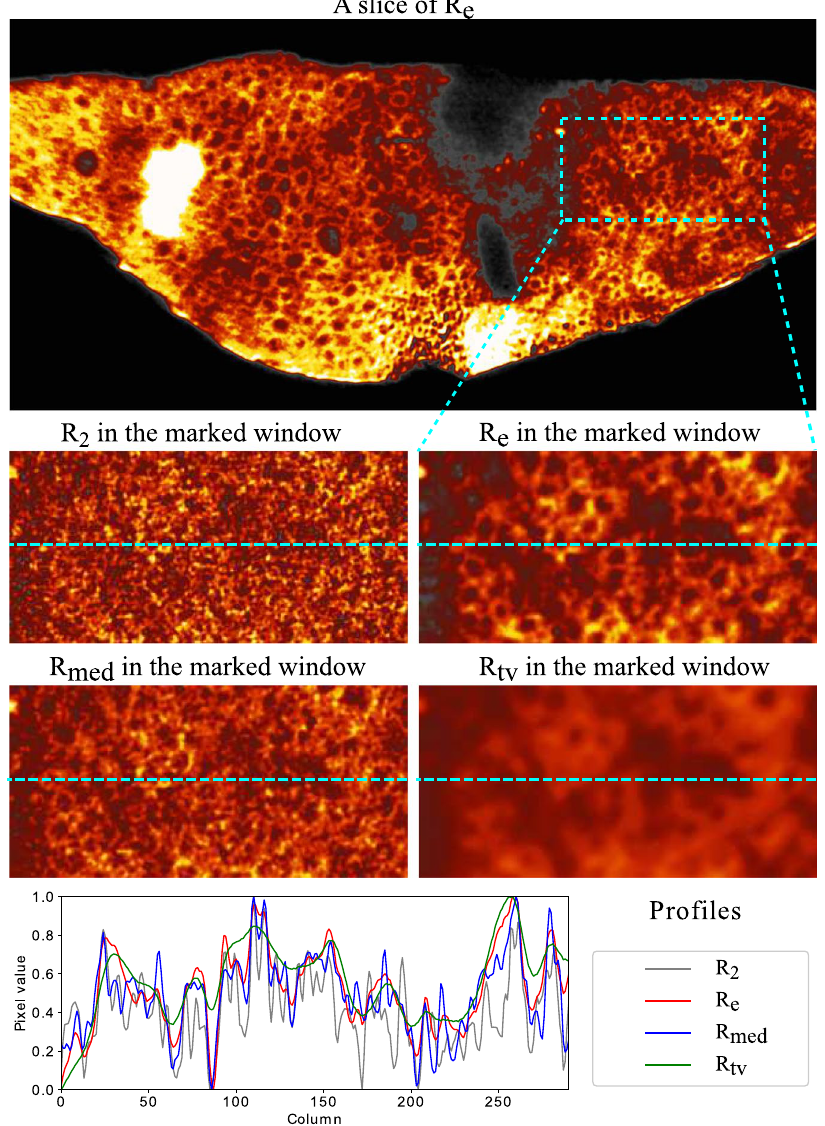
Figure 7. An example of the reconstructions from different quality of the projections of the mouse brain sample. The top row is a slice that reconstructed from the CNN enhanced projections. The four small images in the middle rows are different reconstructions for the section of the blue-dash rectangular window above. They are the reconstructions from the projections with 2 s exposure, the projections enhanced with CNN, the projections denoised with median filter and TV respectively. The plots in the bottom row are the profiles taken from the dash lines of the four small